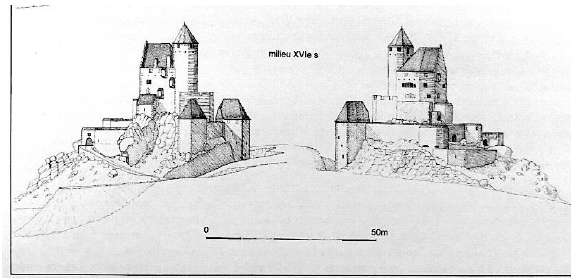
Figure 2: Proposition of graphical restitution of the castle in 1550 (by Mathias Heissler, 2002)